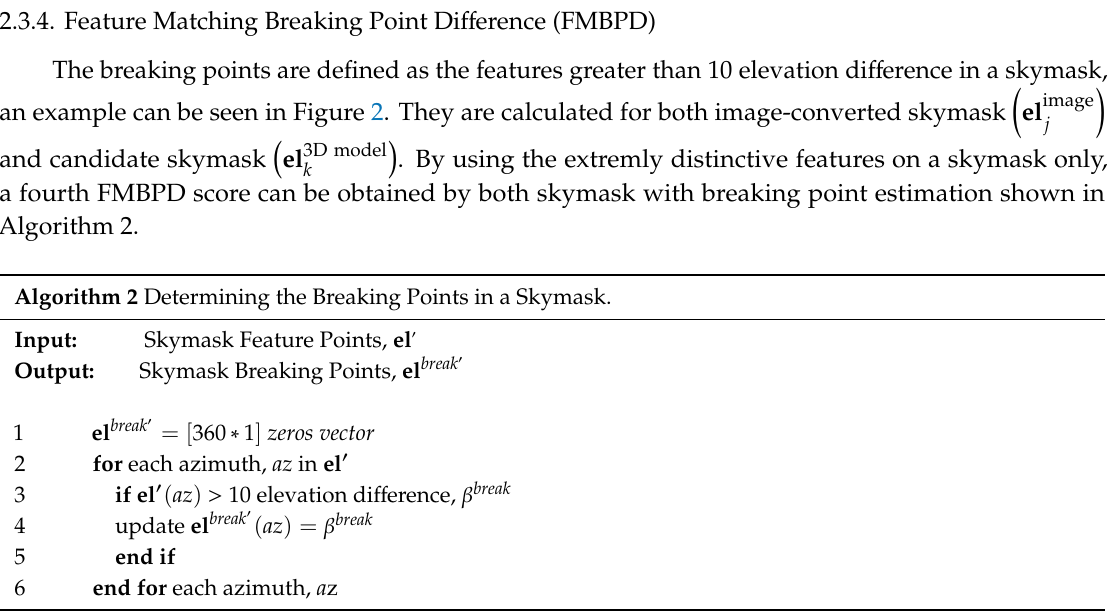
Algorithm 2 Determining the Breaking Points in a Skymask.